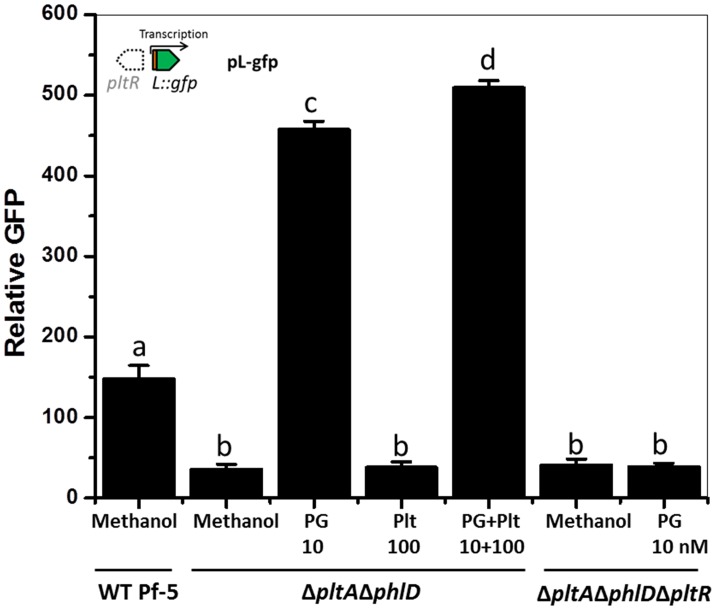
Effect of phloroglucinol (PG) and pyoluteorin on expression of pltL::gfp in P. protegens Pf-5.Pf-5 wild-type and derivatives containing pL-gfp were treated with PG (10 nM) and/or pyoluteorin (100 nM), as indicated. Expression levels of pltL::gfp were measured and recorded as relative GFP (fluorescence of GFP divided by OD600). Letters above columns indicate treatments significantly different from one another, as determined by ANOVA analysis (p<0.05). Data are means of at least three biological replicates from a representative experiment repeated three times with similar results, and error bars represent the standard deviation of the mean.DOI:
http://dx.doi.org/10.7554/eLife.22835.00410.7554/eLife.22835.005Figure 2—source data 1.Expression of pltL::gfp by Pf-5 wild-type (WT) and its derivatives in response to PG and/or pyoluteorin.